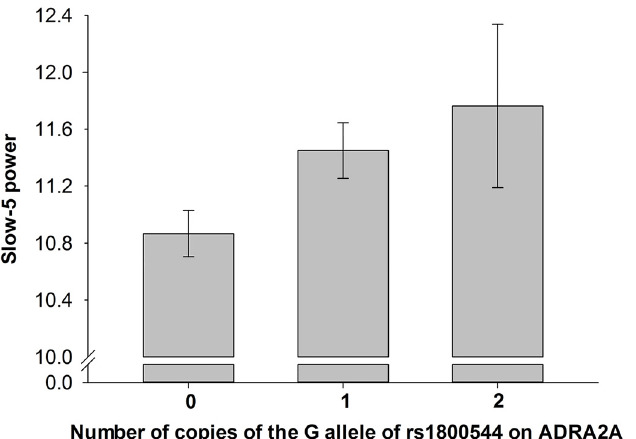
Fig 1. The relationship between genotypic variation at ADRA2A rs1800544 and the low-frequency RT fluctuation measure Slow-5. Relative power in the Slow-5 band (%) increased with each copy of the G